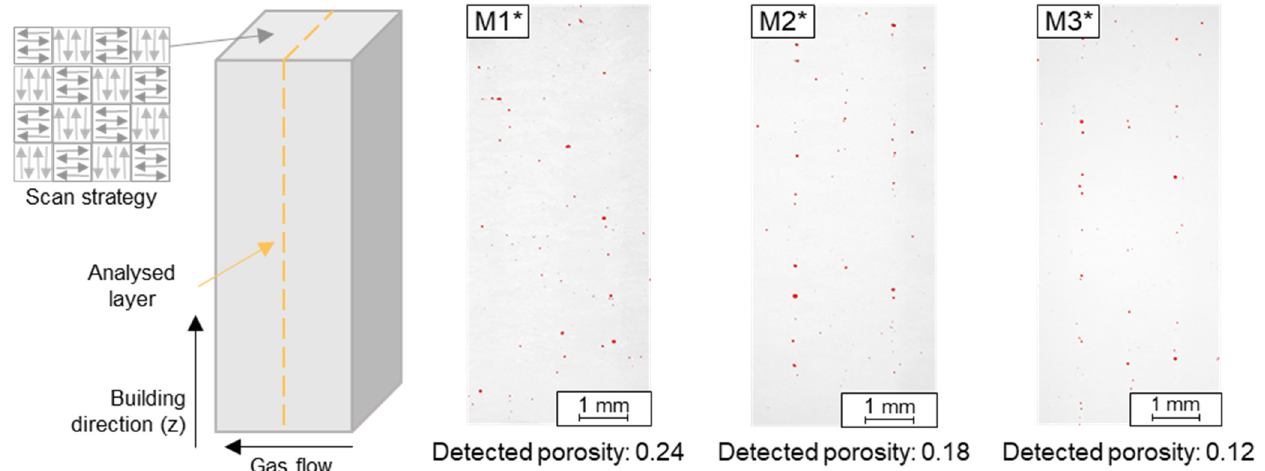
Figure 4. Microscopical image analysis of the optical porosity of M1* ( left ), M2* ( middle ) and M3* ( right ) (the as porous detected areas are highlighted in red).